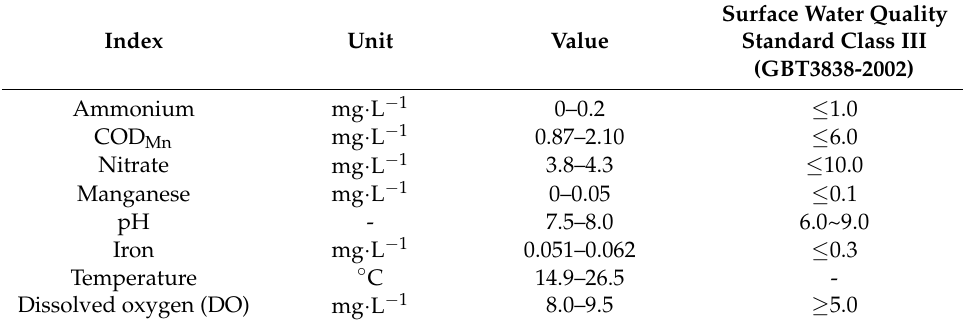
Table 1. Raw water quality.